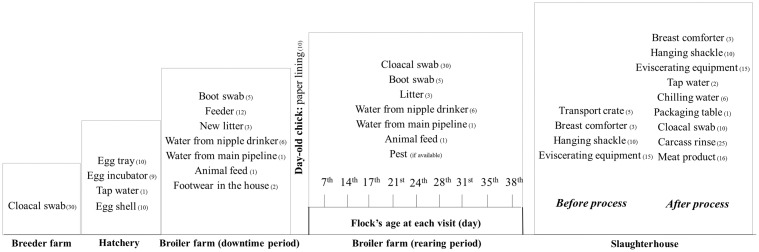
Types and number of samples collected throughout the chicken meat production chain.Area of boot swab sampling at downtime period included anteroom of the target house, inside the target house and area around the house. Area of boot swab sampling during the rearing period included path-leading to the house, anteroom of the target house, inside the target house, area around the house and inside the adjacent house. Flocks D and E were visited at 7th, 14th, 21st, 28th, 35th day of the rearing period, while other flocks were visited at 7th, 14th, 17th, 21st, 24th, 28th, 31st, 35th, 38th day of the rearing period.